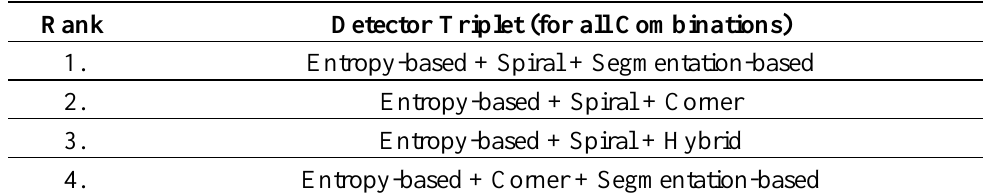
Table 5. Top ranking detector triplets in terms of detector categories.